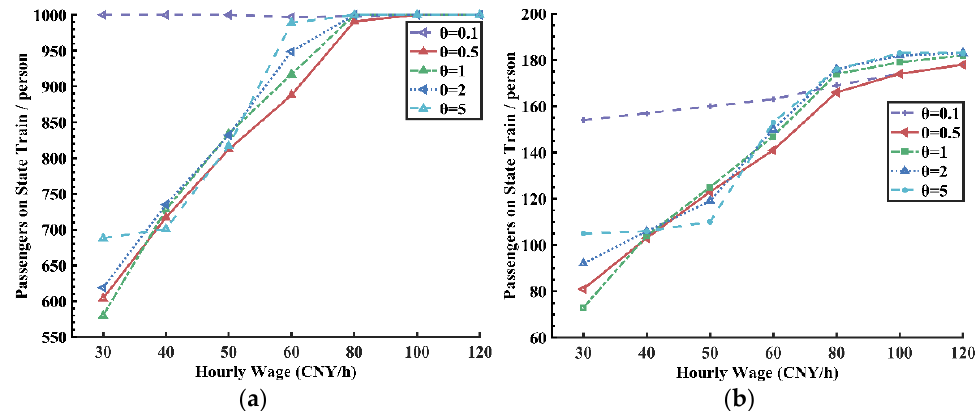
Figure 15. Sensitivity analysis of hourly wages to state train passengers. ( a ) Section between st.5 and st.8. ( b ) Section between st.8 and st.11.